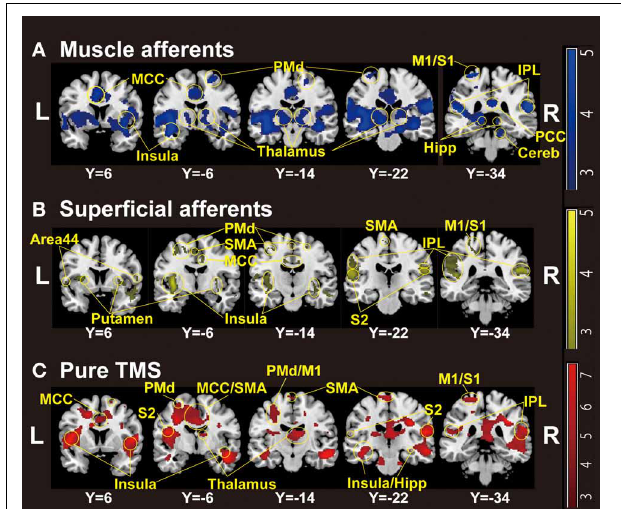
FIGURE 1 | Group-level statistical parametric maps ( n = 18) showing the categorical comparison of conditions (thresholded at P < 0 . 005 uncorrected for display purpose). (A) Muscle afferent-related activity (contrast, motor-MNS minus sensory-MNS). Brain activation was observed in bilateral insula, middle and posterior cingulate cortices, bilateral thalami, bilateral dorsal premotor cortices, bilateral hippocampi, bilateral inferior parietal cortices, right cerebellum, left M1, and left S1. (B) Superficial afferent-related activity (conjunction, motor-MNS and sensory MNS). Brain activation was observed in bilateral Area 44, bilateral putamen, bilateral insula, middle cingulate cortex, bilateral dorsal premotor cortices, SMA, bilateral S2, bilateral inferior parietal cortices, left M1, and left S1. (C) Supra-TMS-induced activity after removing the effects of muscle afferent-induced activity [contrast, (supra-TMS minus implicit baseline) minus (motor-MNS minus sensory-MNS)]. Brain activation was observed in bilateral insula, middle cingulate cortex, SMA, bilateral thalami, bilateral hippocampi, bilateral S2, bilateral inferior parietal cortices, left dorsal premotor cortex, left M1, and left S1. MCC , middle cingulate cortex; PCC , posterior cingulate cortex; SMA , supplementary motor cortex; PMd , dorsal premotor cortex; M1 , primary motor cortex; S1 , primary somatosensory cortex; S2 , secondary somatosensory cortex; IPL , inferior parietal lobule; Hipp , hippocampus; Cereb ,